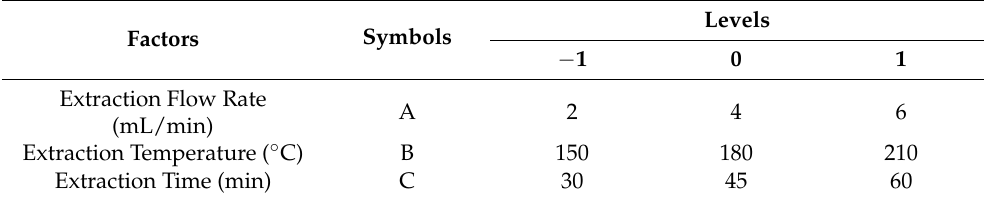
Table 1. Range and levels of experimental variables for the RSM. Levels Factors Symbols − 1 0 1 Extraction Flow Rate A 2 4 6 (mL/min) Extraction Temperature ( ◦ C) B 150 180 210 Extraction Time (min) C 30 45